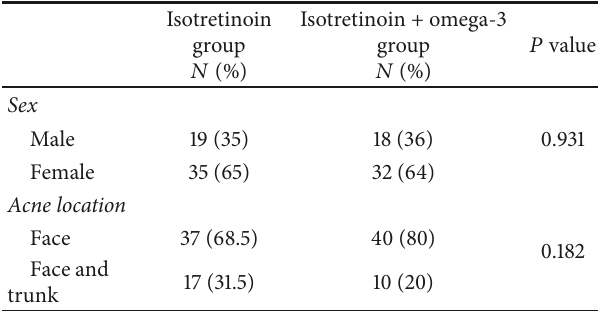
Table 1: Comparison of the frequency of sex and location of acne in case and control